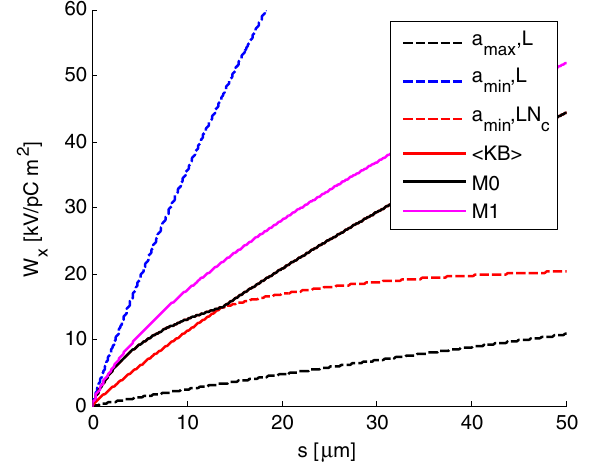
FIG. 8. Short-range transverse wake functions were calculated using the KB* model in the periodic structures (dashed lines): first cell (black), last cell (blue), and last iris spaced by LN (red); and using different models for the tapered structure (solid lines): h KB i (red), M0 (black), M1 (magenta).